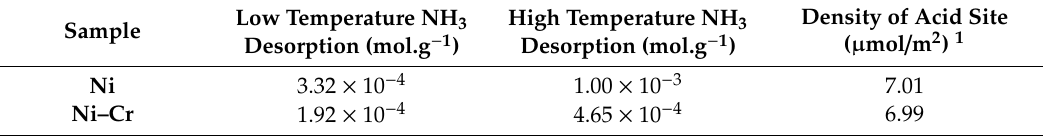
Figure 5. NH 3 -TPD of Ni and Ni–Cr catalysts. m / e = 17. Table 4. NH 3 desorption at low and high